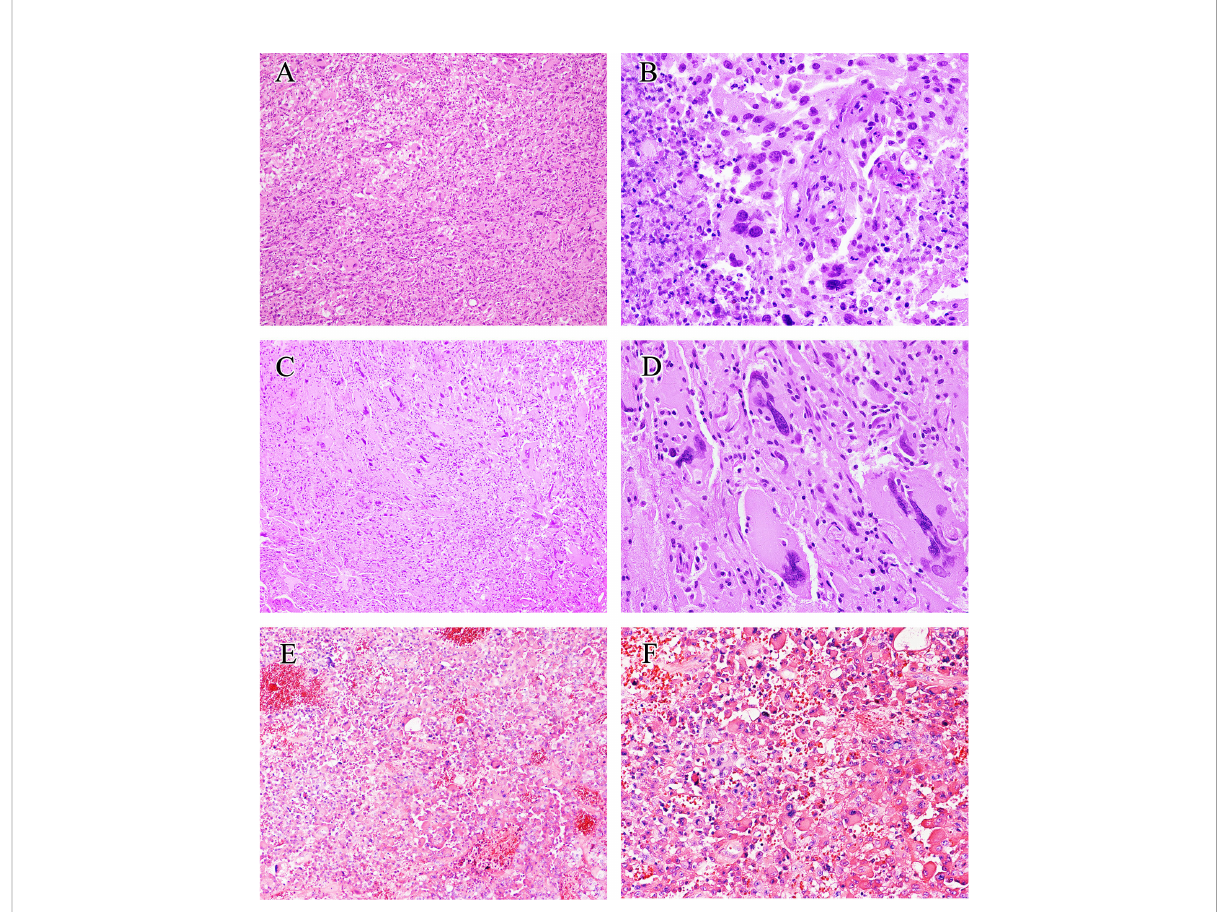
FIGURE 2 Histological fi ndings of eGBM. (A) Patches of epithelioid and rhabdoid cells were presented (×200). (B) The tumour showed microvascular proliferation and zonal necrosis, and epithelioid and rhabdoid cells constituted abundant and uniformly eosinophilic cytoplasm and laterally located oval to pleomorphically shaped nuclei. Mitoses could easily be seen (×400). ( C, D ) PXA-like components in eGBM cases showed multinucleated pleomorphic cells, a fascicular arrangement of spindle-shaped cells and single large bizarre cells (×200 and ×400). (E, F) Histopathological fi ndings of case 13 ( IDH -mutant astrocytoma). The tumour presented epithelioid morphology (×200 and ×400).